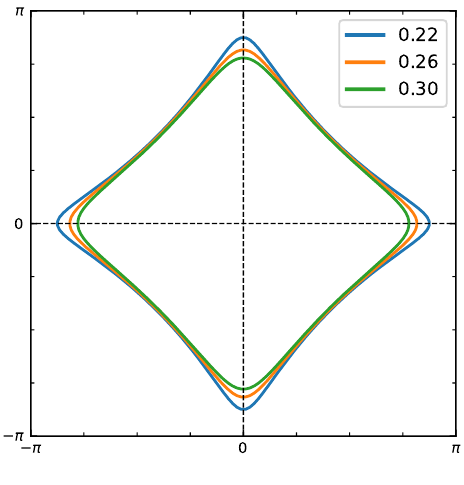
Figure 5: Tight binding parameterization for three dopings, p = 0.22,0.26,0.30 in OD LSCO based on ARPES spectra by Yoshida [ 40 ] . The FS contains both electron- and hole-like curvature which, coupled with an anisotropy in (cid:96) ( k ) at low- T , leads to contributions to σ of different x y